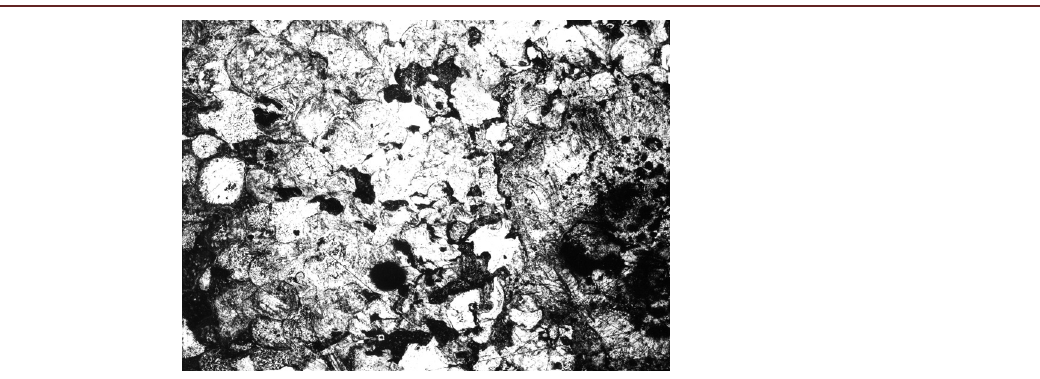
Figure 4: The structures of the cross section of the sample loaded at D =5.12 km/s and thickness of the explosive charge 10 mm.